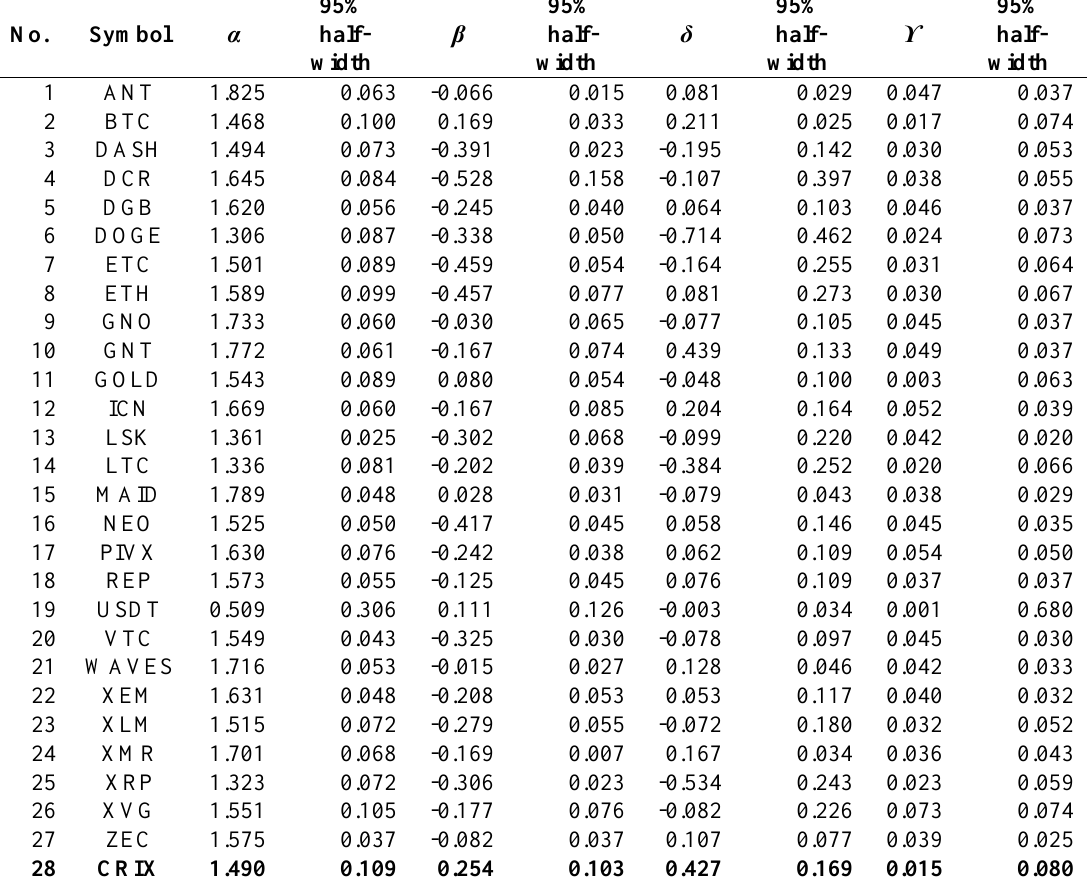
Table 2 : Parameters of the estimated alpha - stable